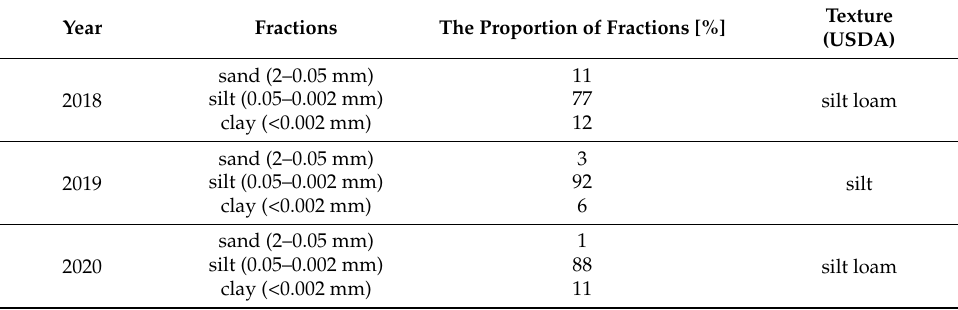
Table 2. Soil granulometric composition during the 3-year field